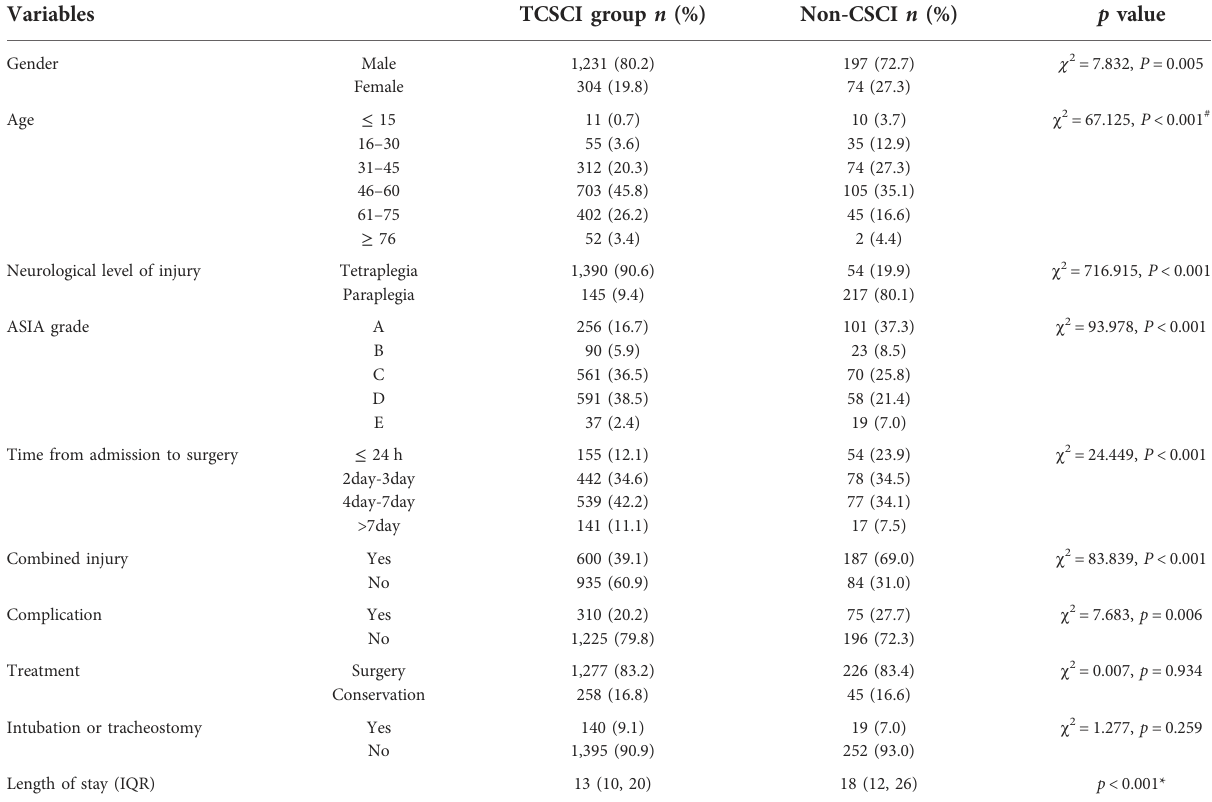
TABLE 5 Characteristics of 1,806 patients resulted from TCSCI and